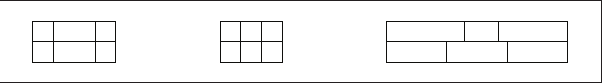
FIGURE 2: Rectangle divided into six